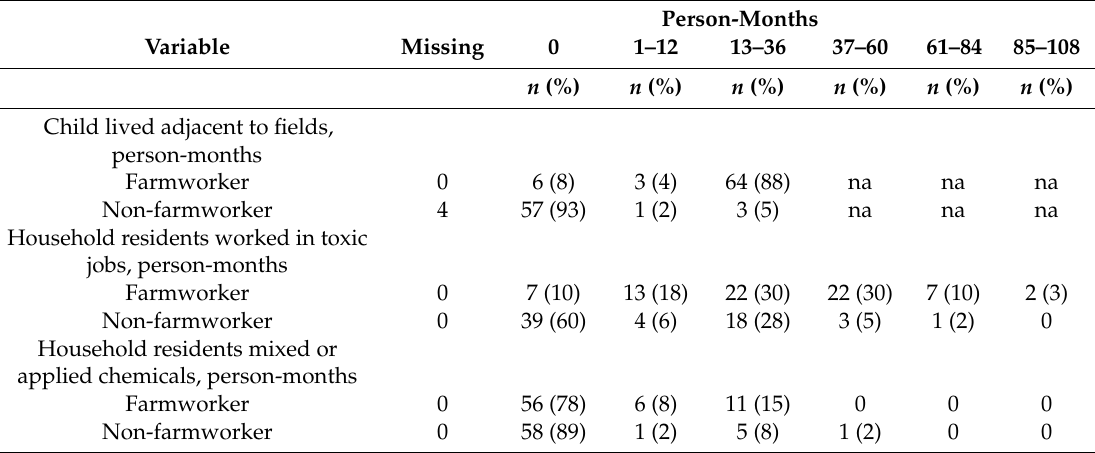
Table 2. Early childhood (birth-35 months) exposure to pesticides and other toxic chemicals, comparing number and non-missing percentages for person-month ranges, by children in farmworker ( n = 73) and non-farmworker ( n = 65) families.